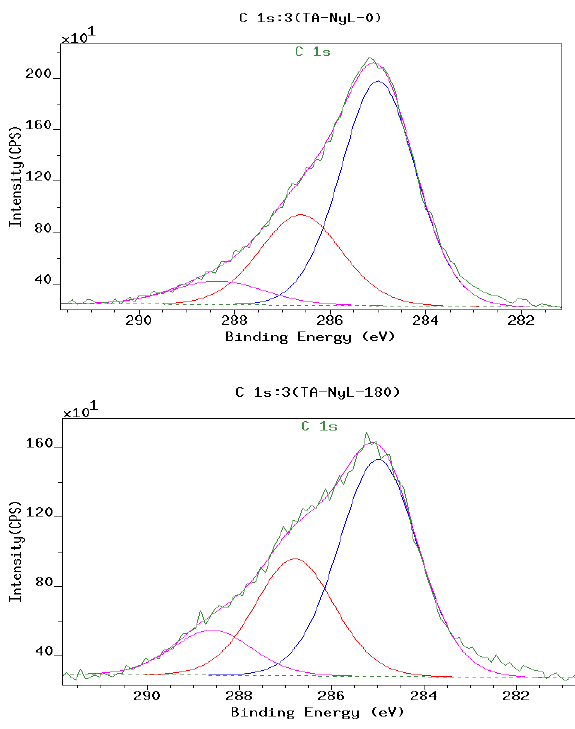
Figure 5: Decomposition of the C 1s peak. Upper: raw, untreated linen; lower: plasma treated for 180